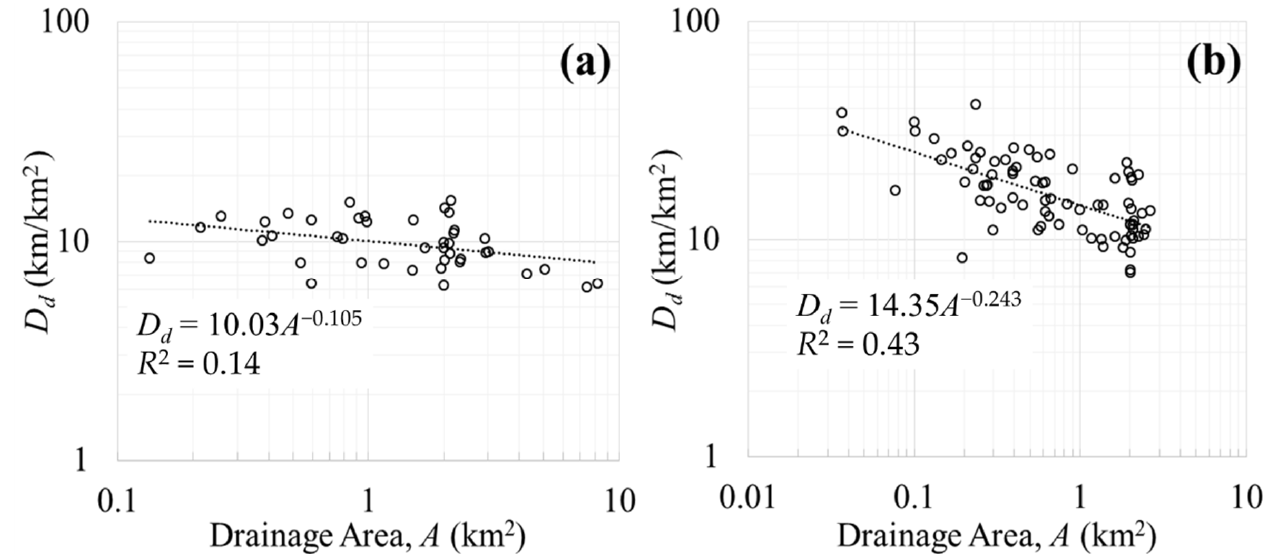
Figure 10. The relationship between drainage density ( 𝐷 (cid:3031) ) and drainage area from the watersheds in this study: ( a ) 42 watersheds from the humid region ( 𝐸 (cid:3017) /𝑃 < 1) and ( b ) 79 watersheds from the arid region ( 𝐸 (cid:3017) /𝑃 > 1).